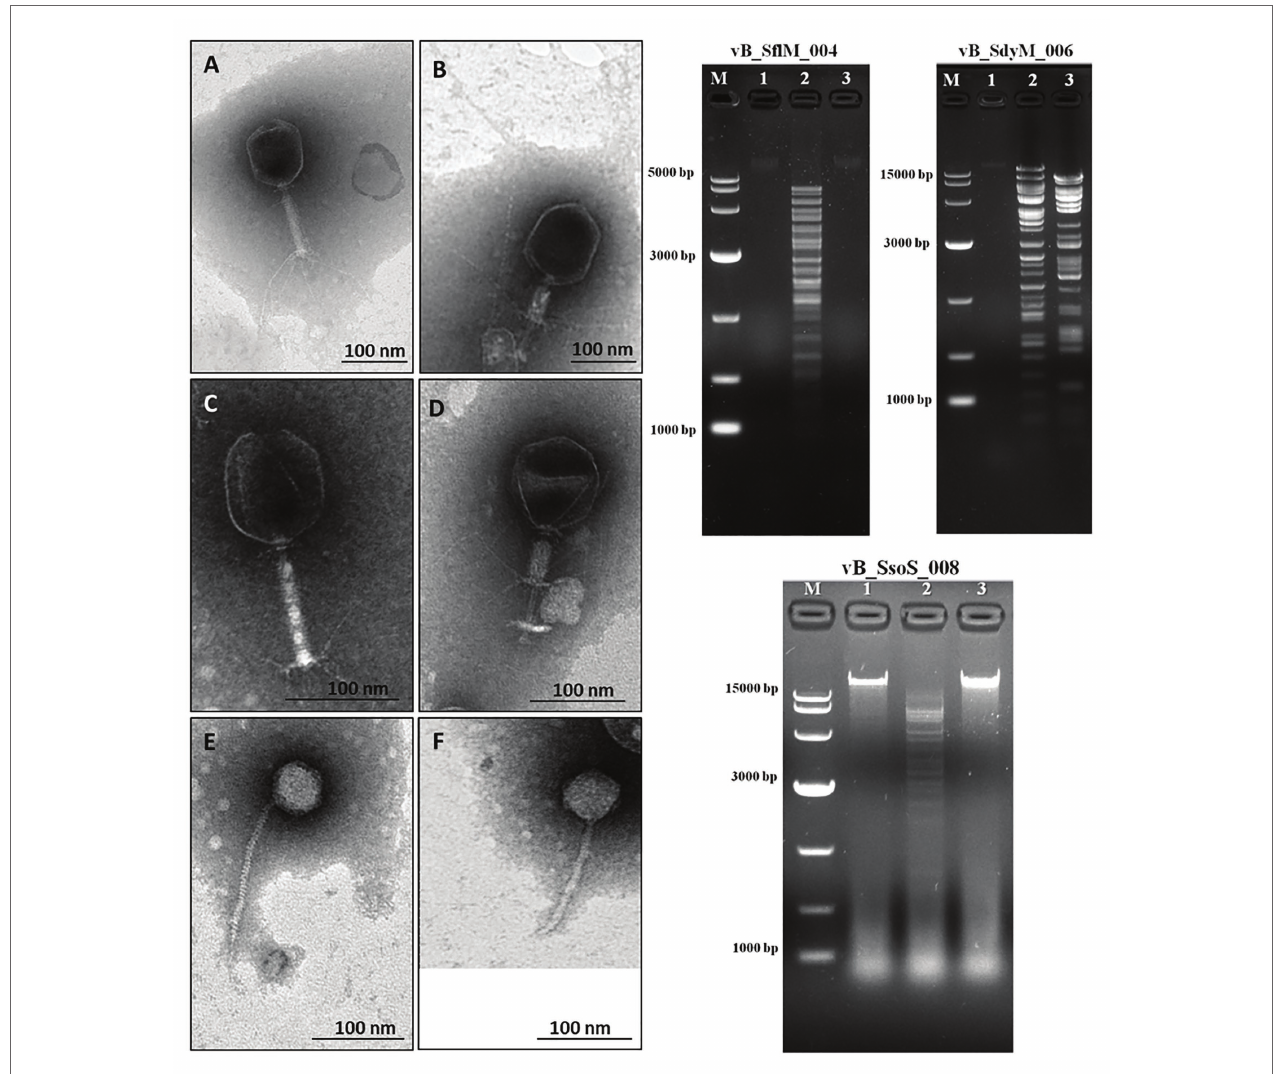
FIGURE 1 | (Left side) The electron micrograph of phages vB _SflM_004 (A,B) , vB_SdyM_006 (C,D) , and vB_SsoS_008 (E,F) . The samples were negatively stained with 2% phosphotungstic acid (PTA). Scale bars 100 nm. (Right side) The DNA fingerprinting analysis of the genomic DNA of phage vB _SflM_004, vB_SdyM_006, and vB_SsoS_008. The genome was digested with EcoRI (line1), EcoRV (line2), and HindIII (line3). M line represents the DNA